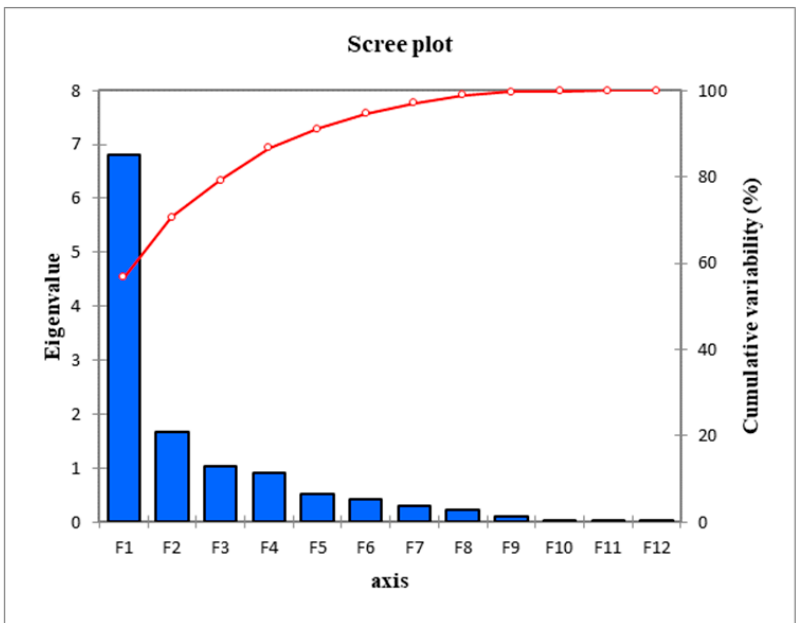
Figure 1. The eigenvalues from the initial PCA.